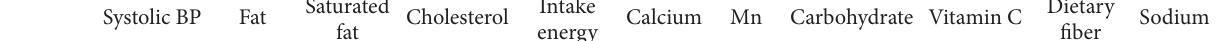
Table 3: Correlation of systolic blood pressure with the variables of dietary behavior in controlled hypertension group. Systolic BP Fat